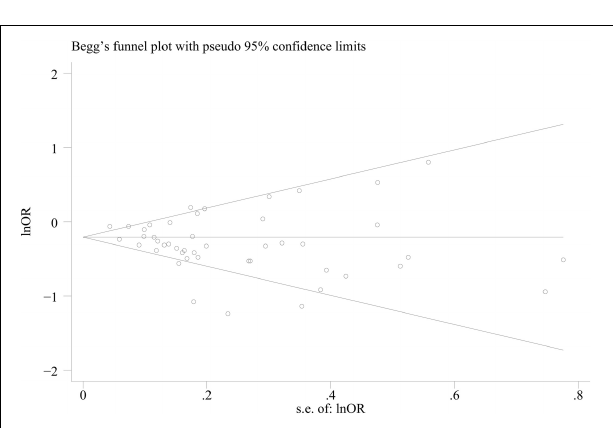
FIGURE 4 | Begg’s funnel plot for identifying publication bias ( n =